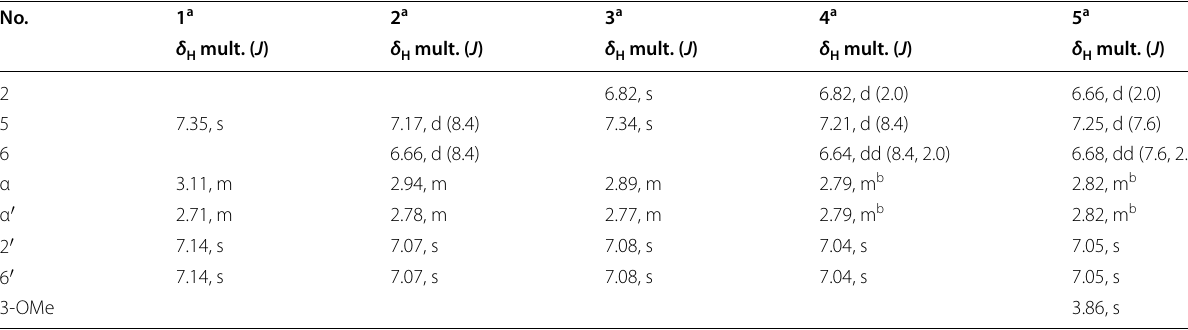
Table 2 1 H NMR data of compounds 1 – 5 No.